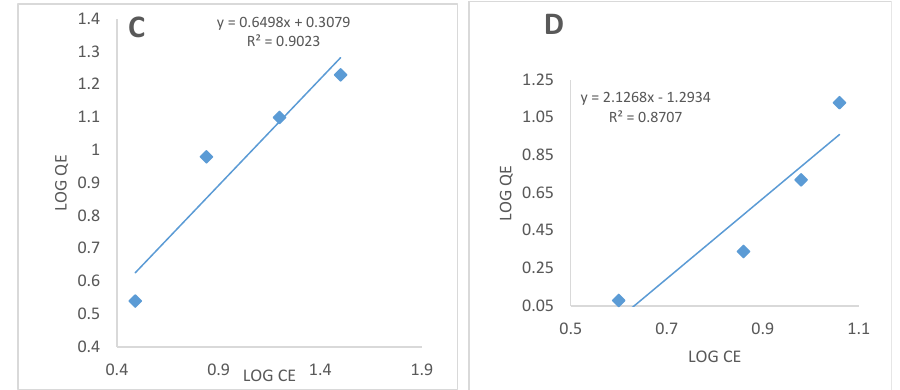
Figure 19. The Freundlich Isotherm Model adsorption for Pb(II) onto ( C ) adsorbent 1 and ( D ) adsorbent 2 . (Experimental conditions: dosage = 0.015 g (adsorbent 1 ) and 0.1 (adsorbent 2 ) per 50 mL; T = 25 ± 1 °C; contact time = 60 min.; pH = 6.5 ± for Pb(II). Table 5. Coefficients of two different sorption isotherm models for Pb(II) removal by adsorbents 1 and 2 and their correlation coefficient (R 2 ). (Experimental conditions: dosage = 0.015 g (adsorbent 1 ) and 0.1 (adsorbent 2 ) per 50 mL; T = 25 ± 1 °C; contact time = 60 min.; pH = 6.5 ± 0.2 for Pb(II).